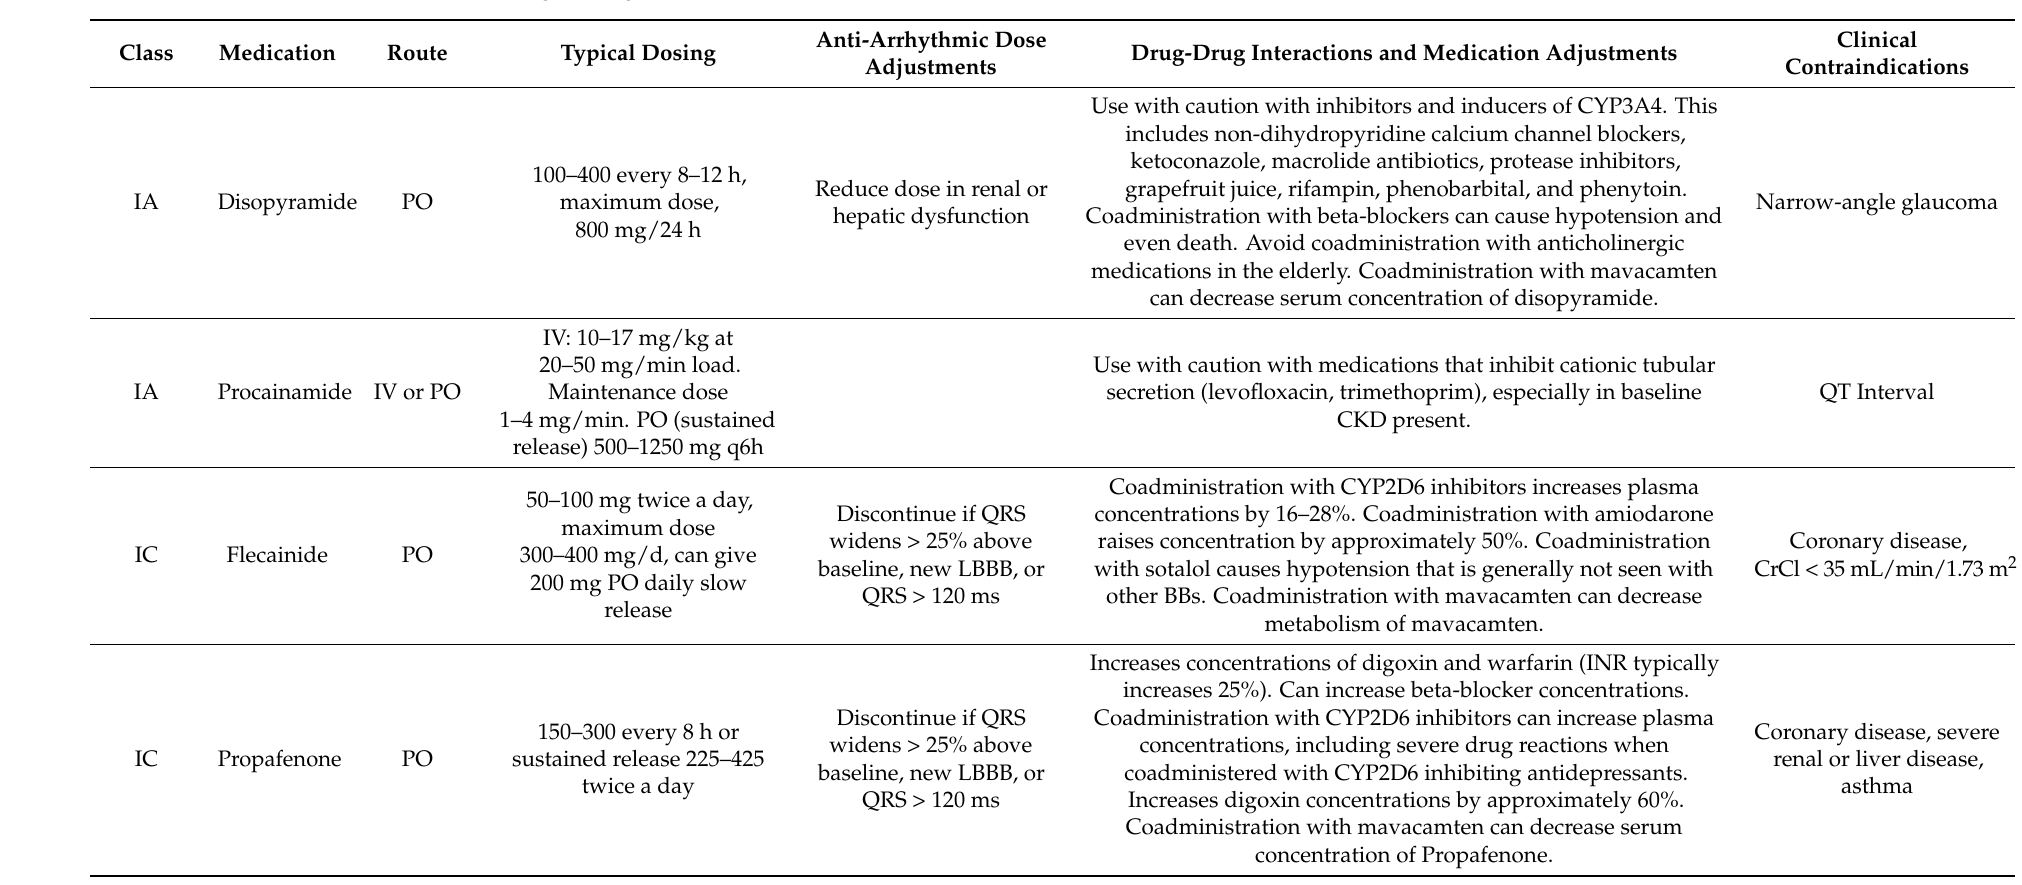
Table 1. Drug-to-drug